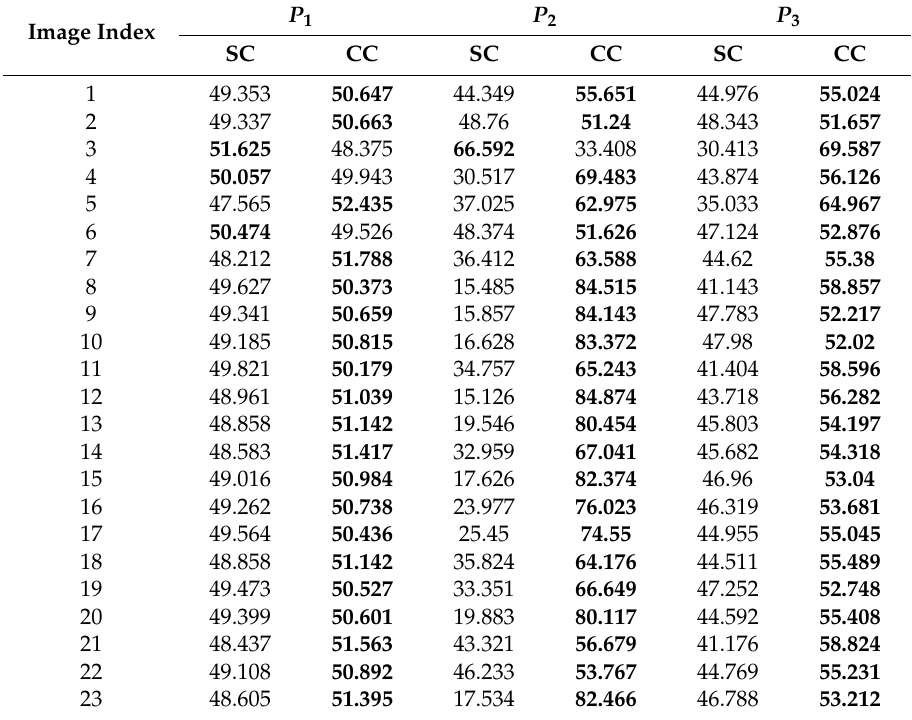
Table 3. The measured P 1 , P 2 , P 3 values of SQ_E images using Hessian